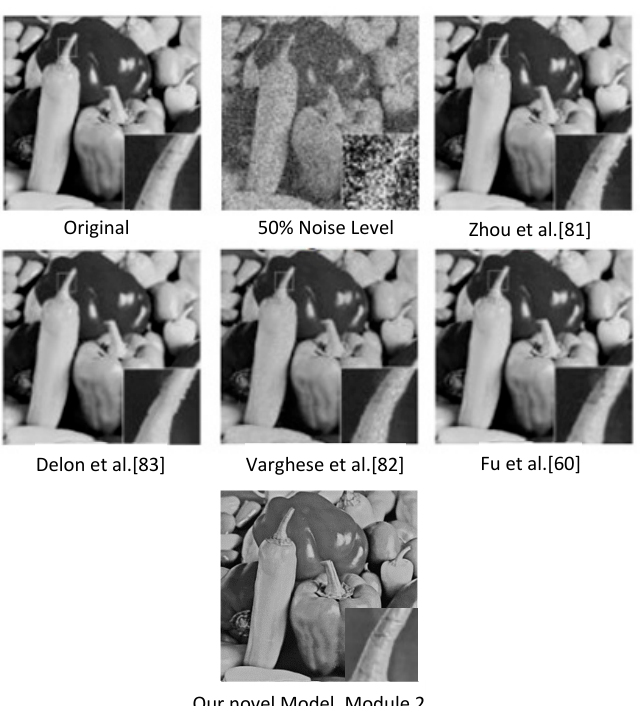
Figure 9. Comparison (visual illustration of the outputs) of the performance of Module 2 for denoising with that of other denoising models from the literature. The top-left image is the original image. We use this image and add 50% noise to that image to compare the output of different denoising models. Notice that our model can also improve image contrast. Table 4. Comparison of the PSNR values of the output images obtained from different denoising models involved in this benchmarking; each column corresponds to a different denoising model. The last column presents the PSNR performance of Module 2.